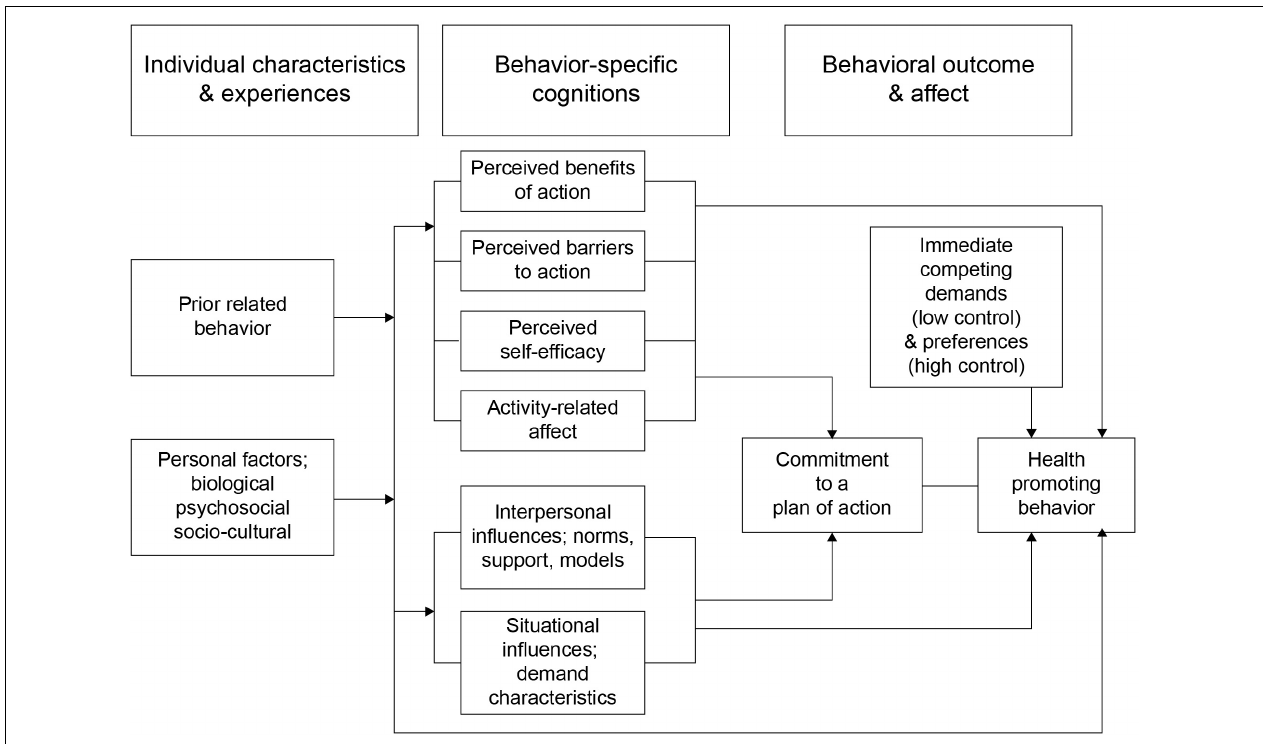
FIGURE 2 | Pender’s health promotion model. (Previous model). Adopted from Pender et al.